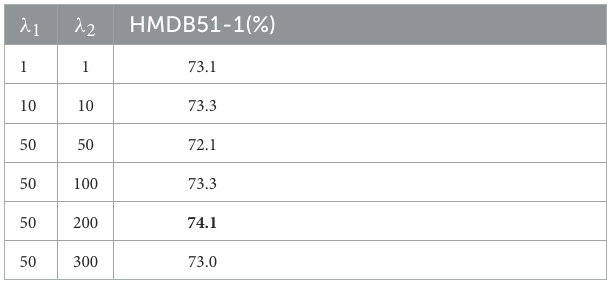
TABLE 2 The influence of CE module position and number.